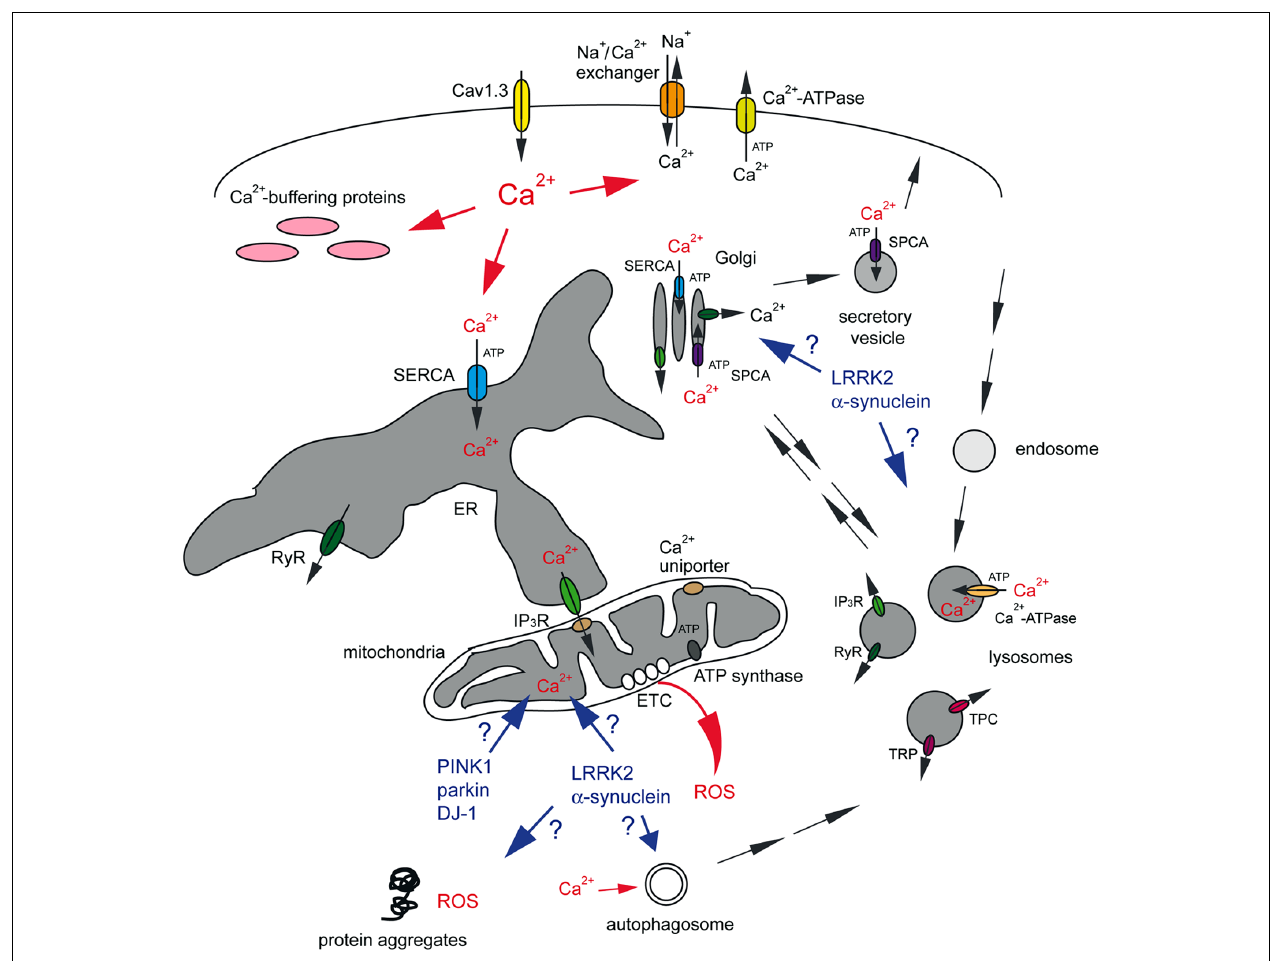
FIGURE 1 |Abnormal Ca 2 + signaling in SNc DA neurons may cause mitochondrial oxidant stress, proteostasis deficits and eventual cell death. Vulnerable neuronal populations display spontaneous slow pacemaking activity employing Cav1.3 L-type Ca 2 + channels,